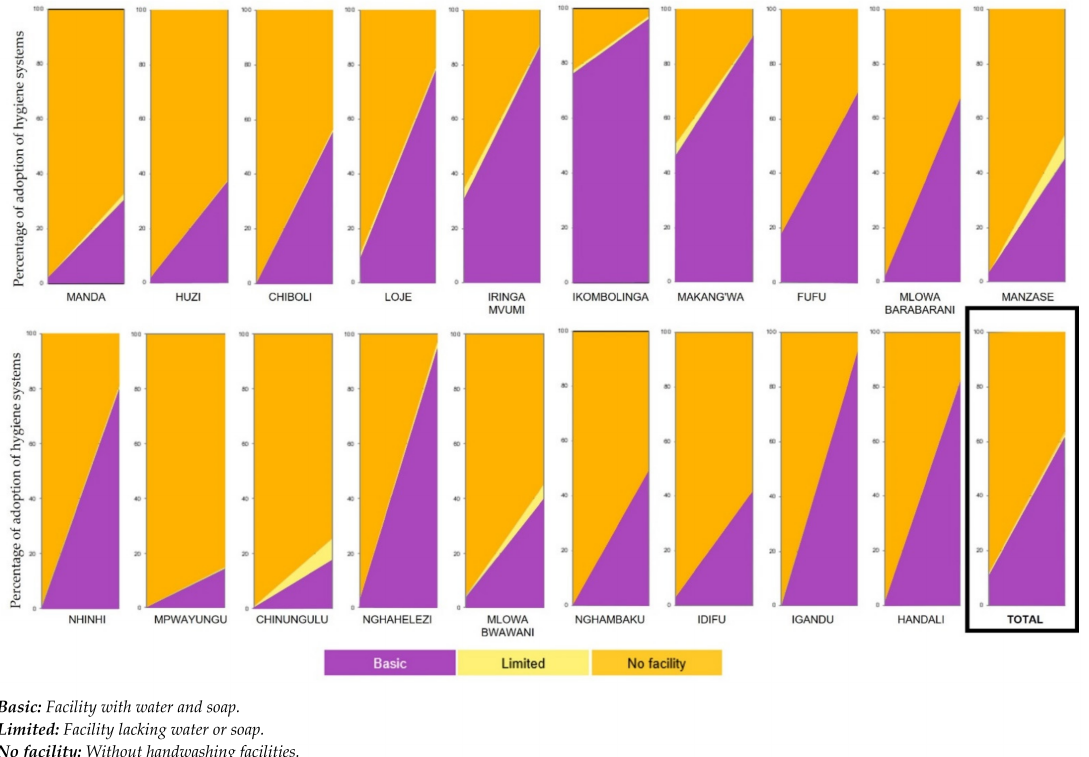
Figure 7. Percentage of adoption of each type of the hygiene ladder in the 19 wards surveyed in the Chamwino District before (baseline) and after (follow-up) the